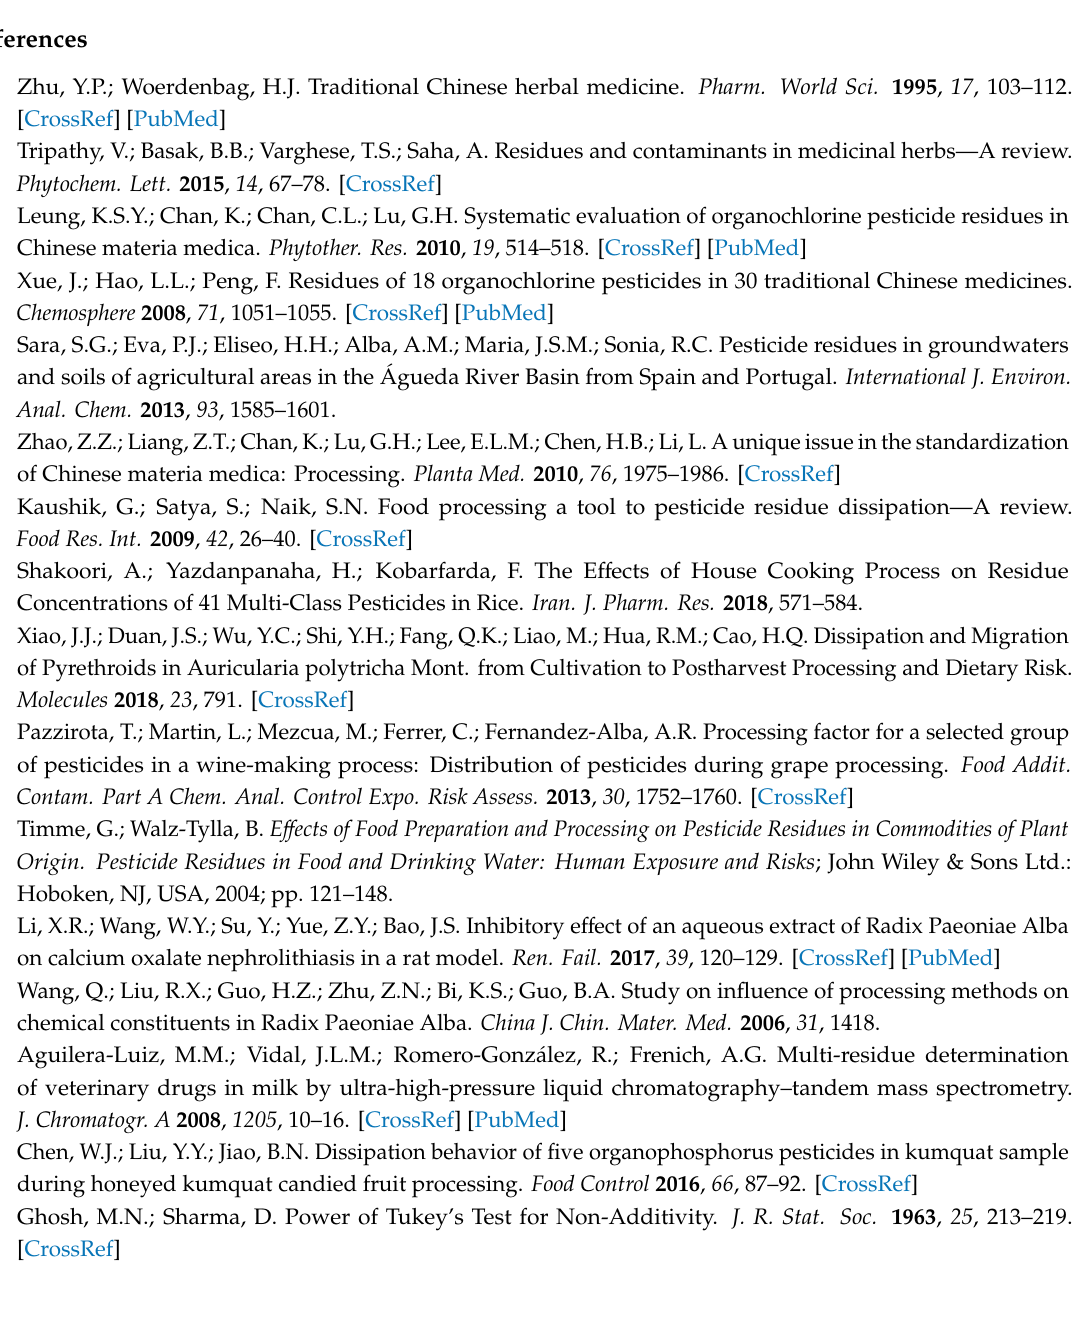
Figure S1. Typical chromatograms of pesticides in control (a) and spiked PRA sample (b) with a standard mixture at 50 µ g / kg; Figure S2. Residues of epoxiconazole, difenoconazole, and azoxystrobin in PRA during